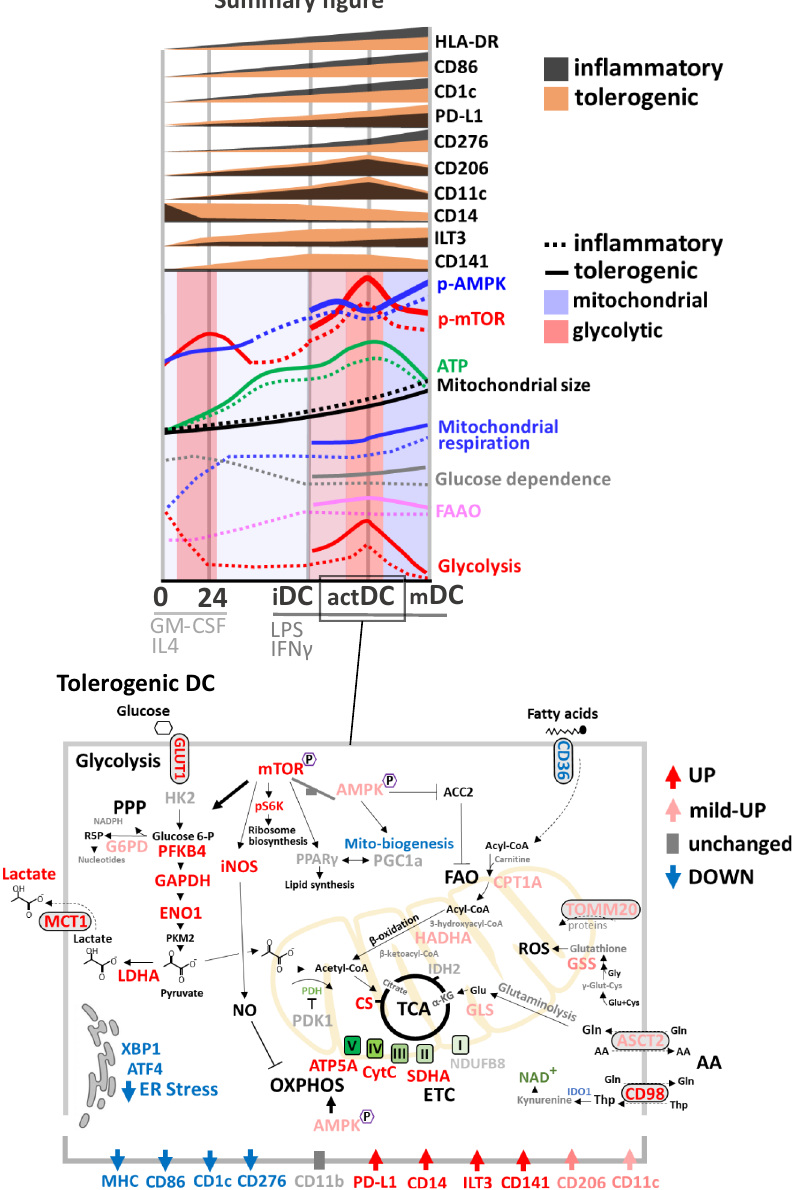
Fig. 8 | Summary diagram of immunometabolic reprogramming of in fl amma- toryandtolerogenicDCduringdifferentiationsignaling. Aschematicdepiction